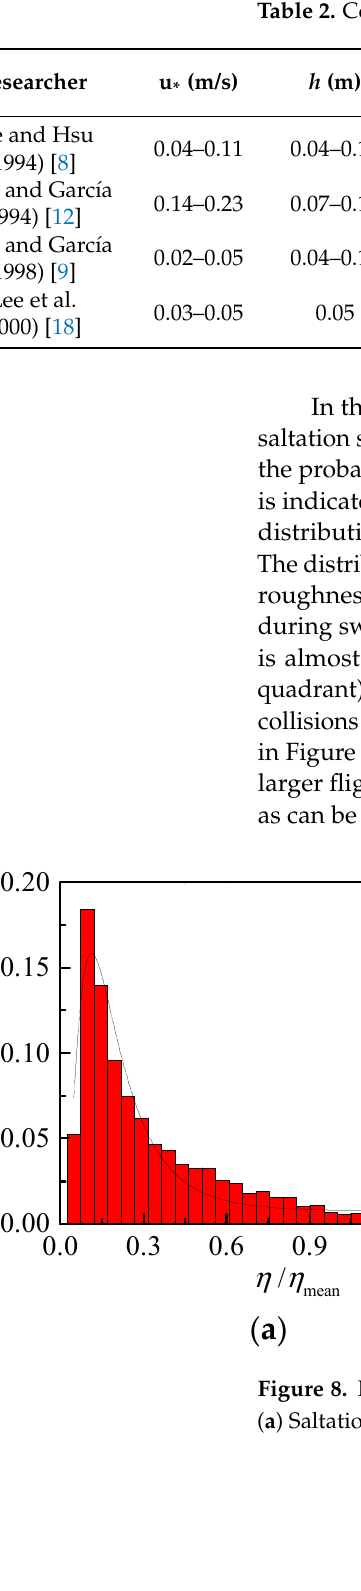
Figure 9. Motion trajectories of sediment particles. The circles indicate the collision position of sed- iment particles. Figure 10. Probability density distribution of saltation time. A comparison of the dimensionless saltation length between the present simulated results and experimental results is plotted in Figure 11. It indicates that dimensionless saltation length increases as the transport stage increases. At the lower transport stage, the simulated results of dimensionless saltation length are very close to the experimental results [9,17], which verify the correctness of the numerical model. At the medium transport stage, the simulated results are larger than the experimental results. Einstein and El-Sammi [64] pointed out that saltation length is affected by particle size and shape; their opinions are verified by the experiment of Lee et al. [18] at the low flow intensity, in